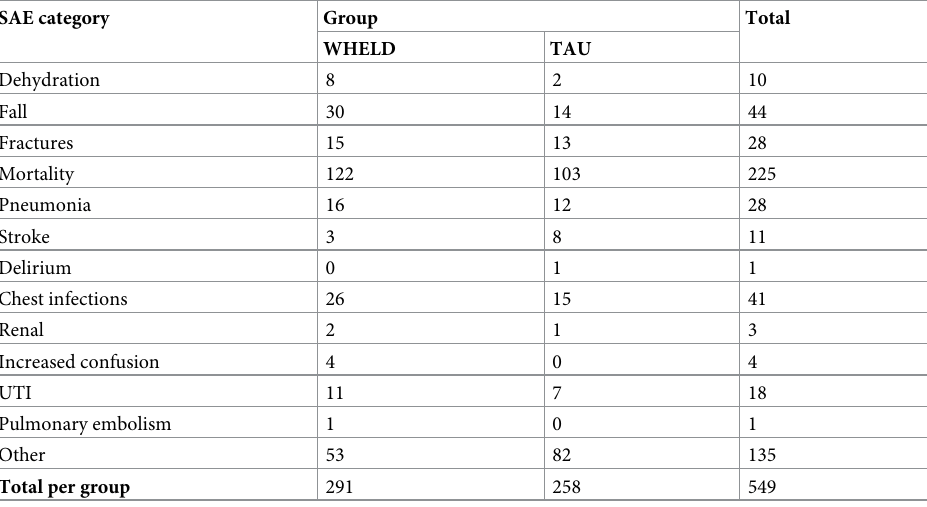
Table 4. Serious adverse event reporting by category and WHELD treatment group.